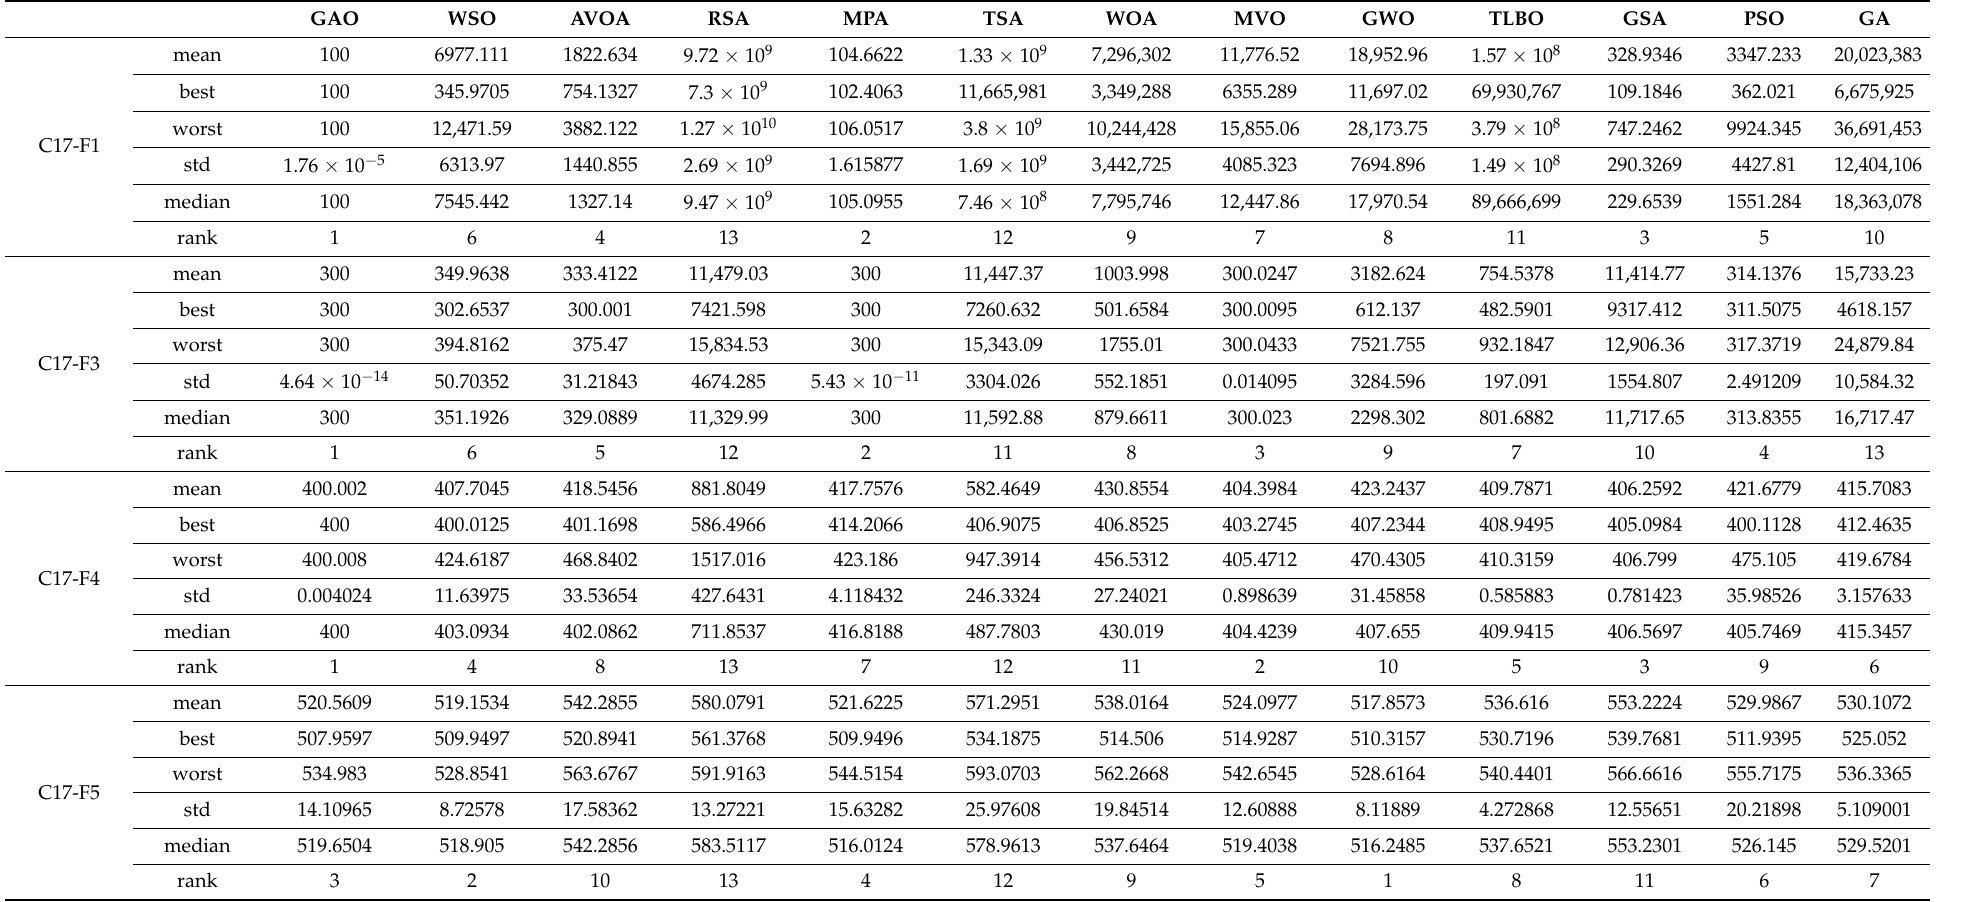
Table 2. Optimization results of the CEC 2017 test suite (dimension m =